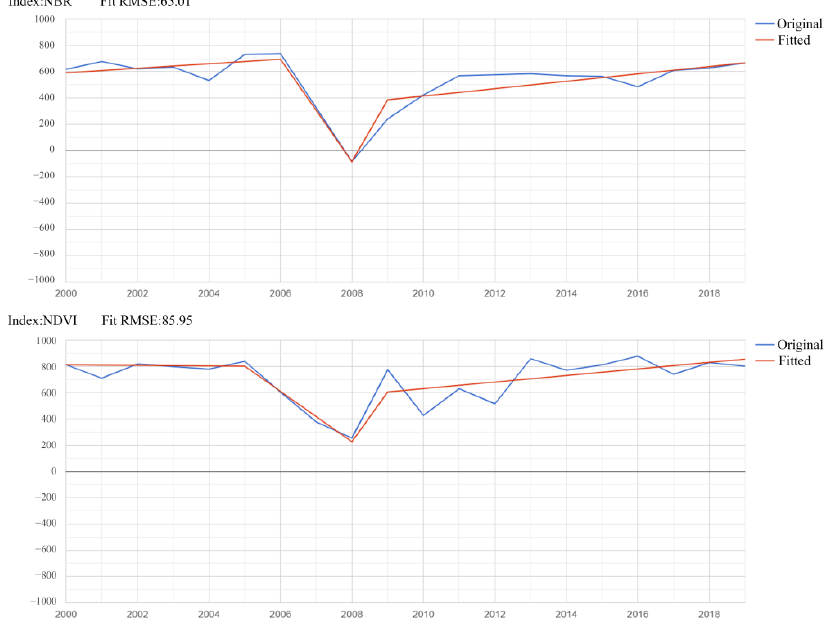
Figure 3. The fitting process of the LandTrendr algorithm. One example of the fitting calculation process. The root mean square error (RMSE) of the final fitting based on NDVI was 85.95 (the actual value should be 0.08595) but the RMSE based on NBR was 65.01 (that is 0.06501), which was slightly lower than that of